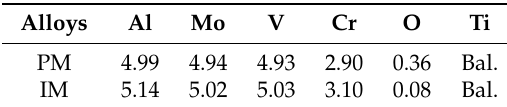
Table 1. Actual chemical composition of the as-consolidated PM and the as-cast IM Ti-5553 alloy (wt.%). Alloys Al Mo V Cr O Ti PM 4.99 4.94 4.93 2.90 0.36 Bal. IM 5.14 5.02 5.03 3.10 0.08